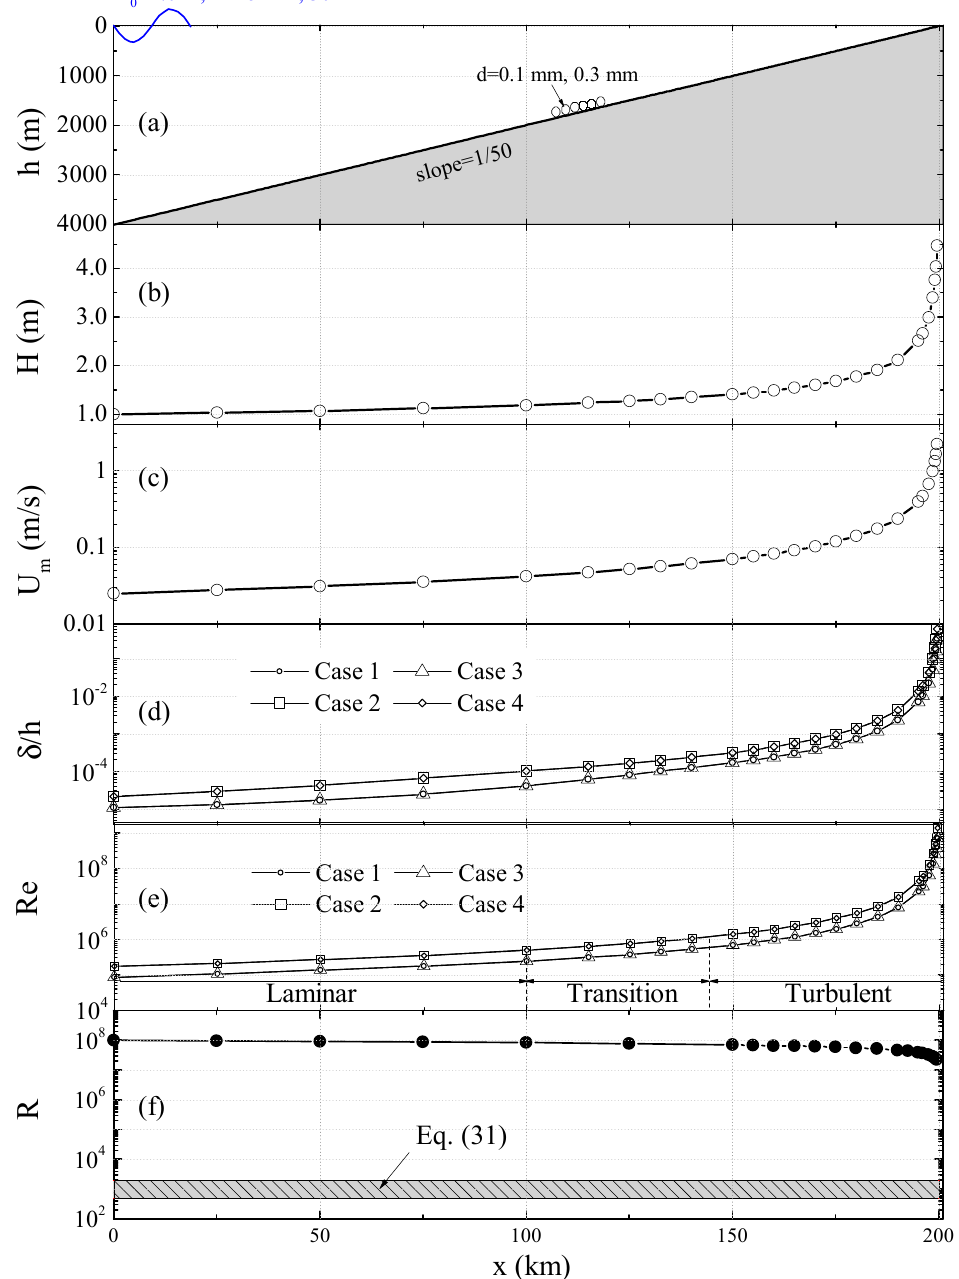
Figure 2. Results for hypothetical shoaling tsunamis. ( a ) Water depth, ( b ) wave height, ( c ) maximum velocity, ( d ) boundary layer thickness, ( e ) wave Reynolds number, and ( f ) steady flow Reynolds number. Following Williams and Fuhrman [6] and Tinh and Tanaka [9], the wave shoaling process from the source to the shallow sea region is obtained by applying Green’s